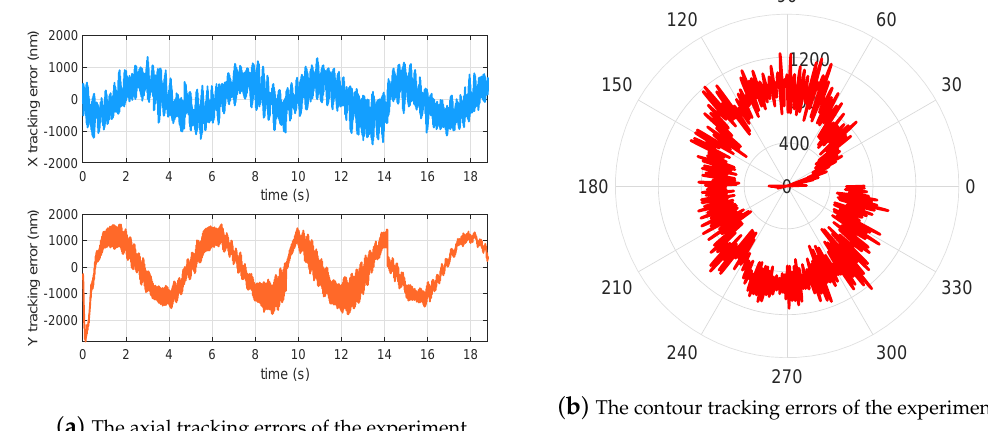
Figure 13. The error analysis of the experimental results.